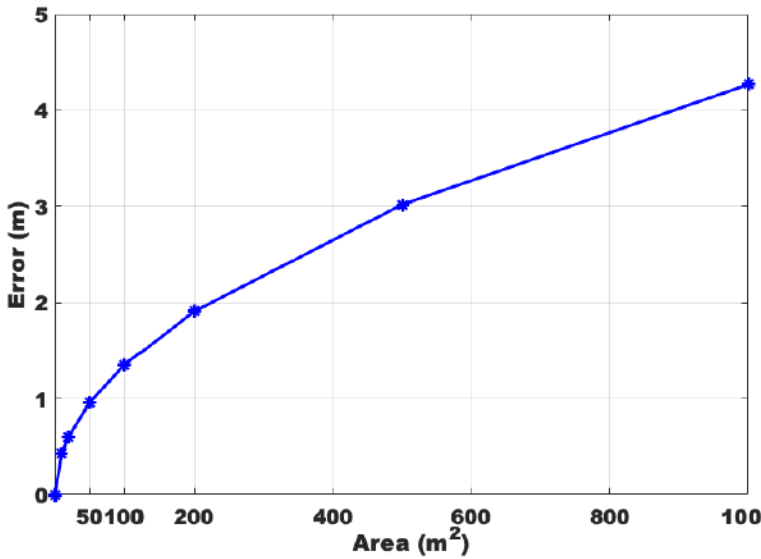
Figure 15. Theoretical value of error variation when using 3 × 3 as the basic